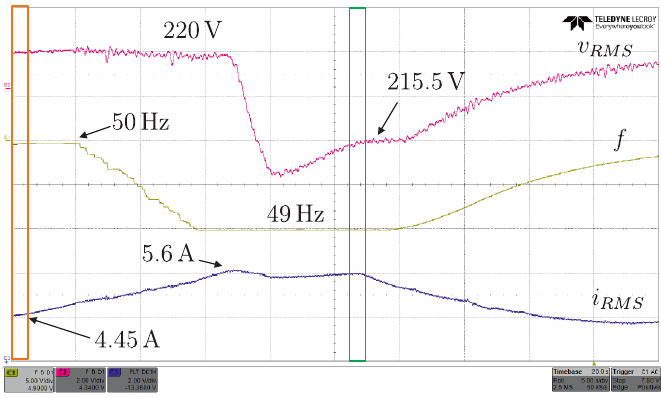
Figure 9. Experimental results: ST rms voltage v LV (magenta line), grid frequency f LV (yellow line), and ST rms current i LV (blue